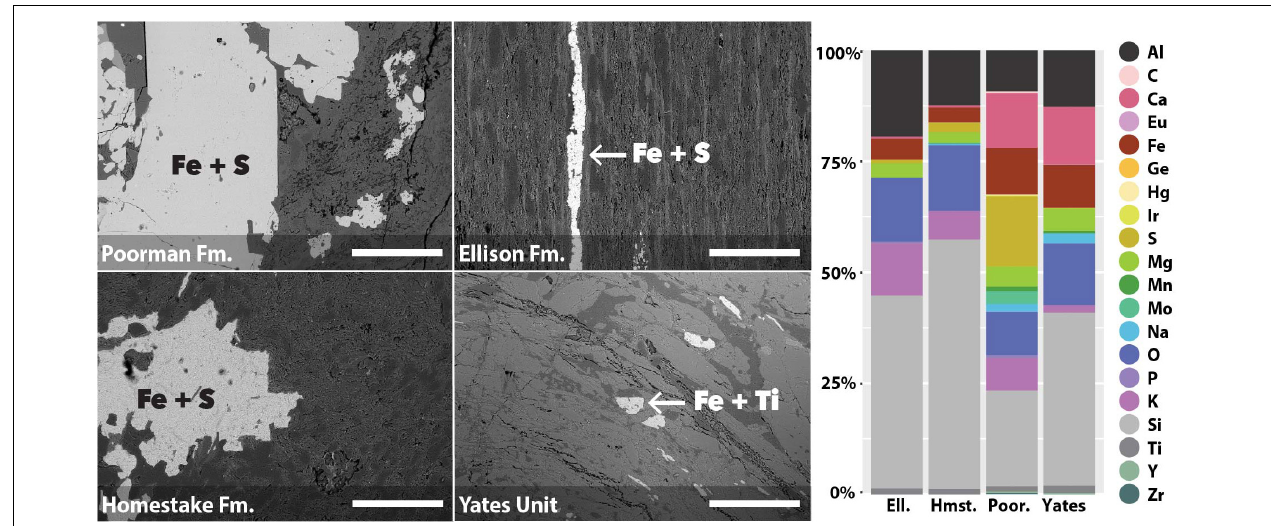
FIGURE 1 | SEM images of rock coupons representing the four major rock units at DeMMO with arrows pointing to examples of mineral grains selected for spatial analyses (left) ; images were collected at 105x magnification, scale bars represent 500 µ m. Bulk chemistry of the four major rock units at DeMMO (right)